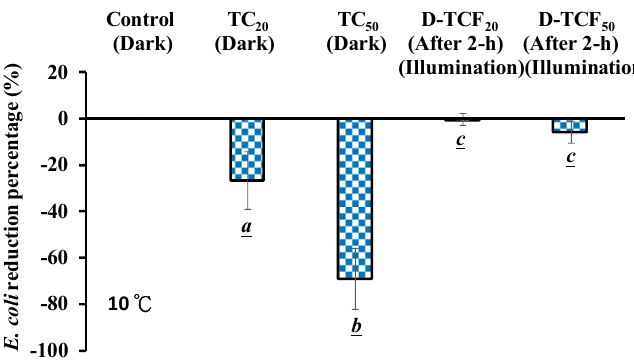
Figure 5. E ff ects of TC and degradation of TC (D-TCF) on E. coli viability at 10 ± 1 ◦ C. Data are expressed as the mean ± SD, where n = 3. Statistically significant di ff erence ( p < 0.05) between an experimental group and the control is indicated by a letter below the each bar. Any two experimental groups that are significantly di ff erent between each other are labeled by di ff erent